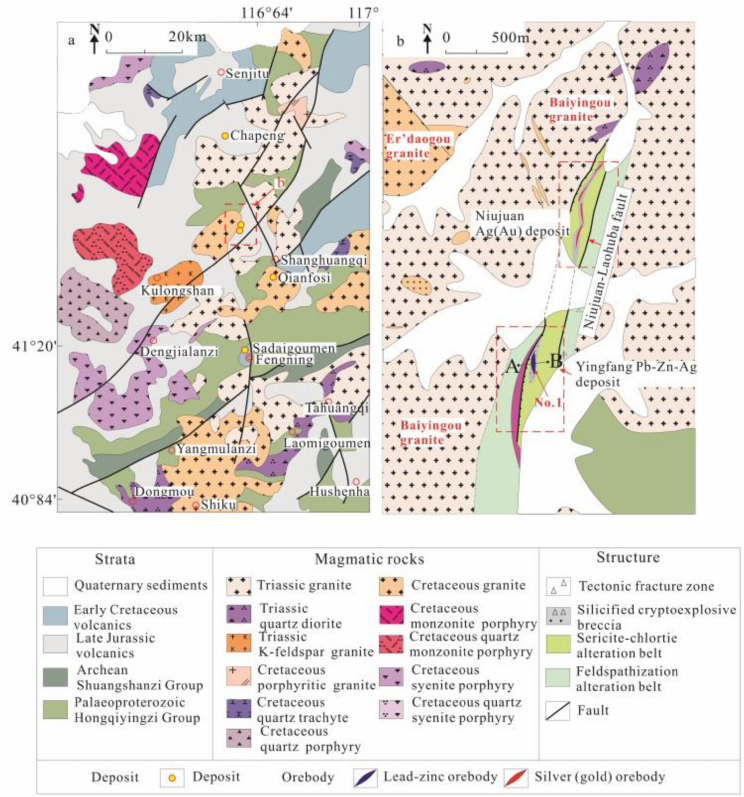
Figure 2. ( a ) Regional geological map of the Fengning area showing the distribution of magmatic rocks (modified from [14]); ( b ) Geological map of the Niujuan Ag (Au) deposit and the Yingfang Pb-Zn-Ag deposit (A–B: exploration line; modified after